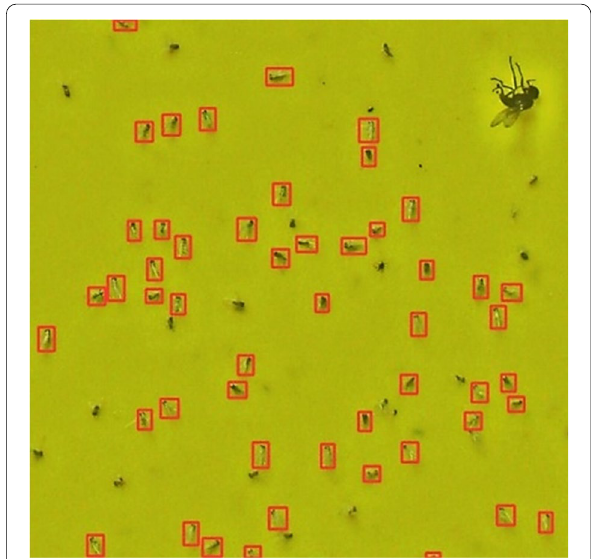
Fig. 1 Example of inference. The objects of interest ( Jacobiasca lybica ) detected by YOLO v5 are marked in red